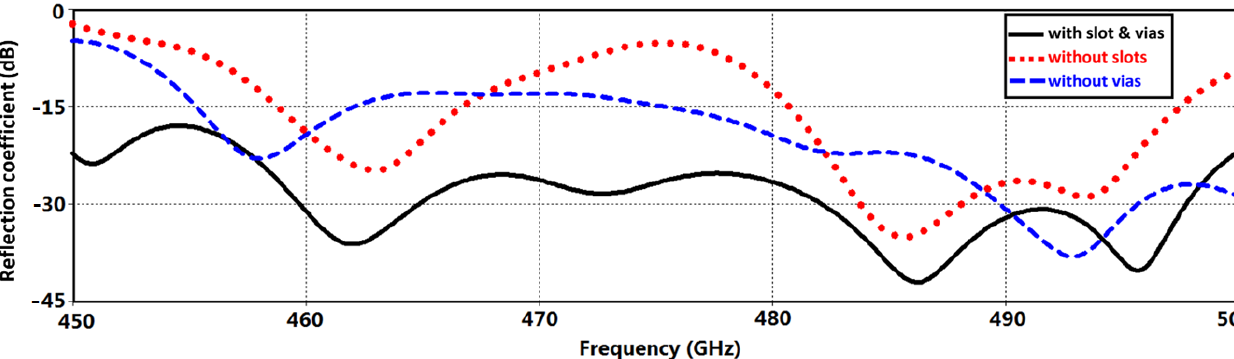
Figure 2. Reflection-coefficient response of the proposed AoC (i) without metamaterial slots, (ii) without metallic vias, and (iii) with metamaterial slots and metallic vias.